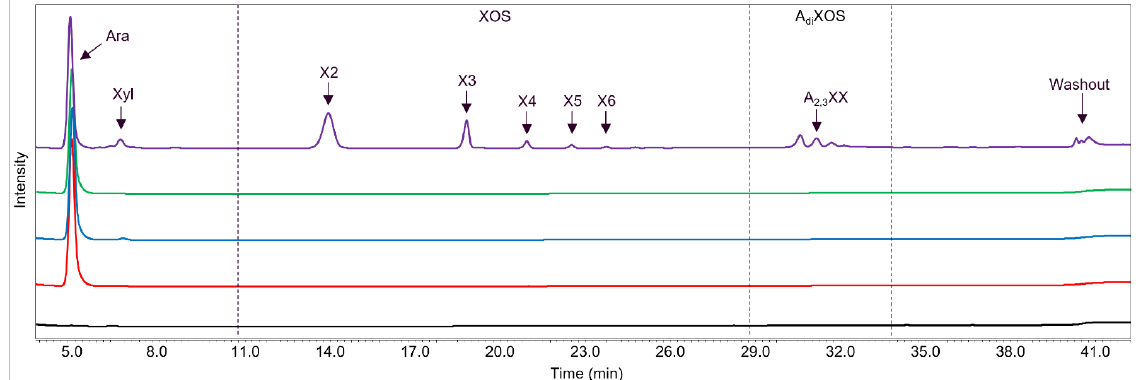
Figure 4. HPAEC reaction product profiles of AX incubated for 24 h without enzyme (black) and with 50 μg mL −1 Mg ABF51 (red), Po ABF62 (blue), Hi ABF43_36a (green), and Tp ABF43_36b (purple). Arabinose (Ara), xylose (Xyl), XOS (DP 2 to 6), and disubstituted AXOS (A di XOS) were detected. Reaction conditions are displayed in Section 4.2.2, exp. # 1.